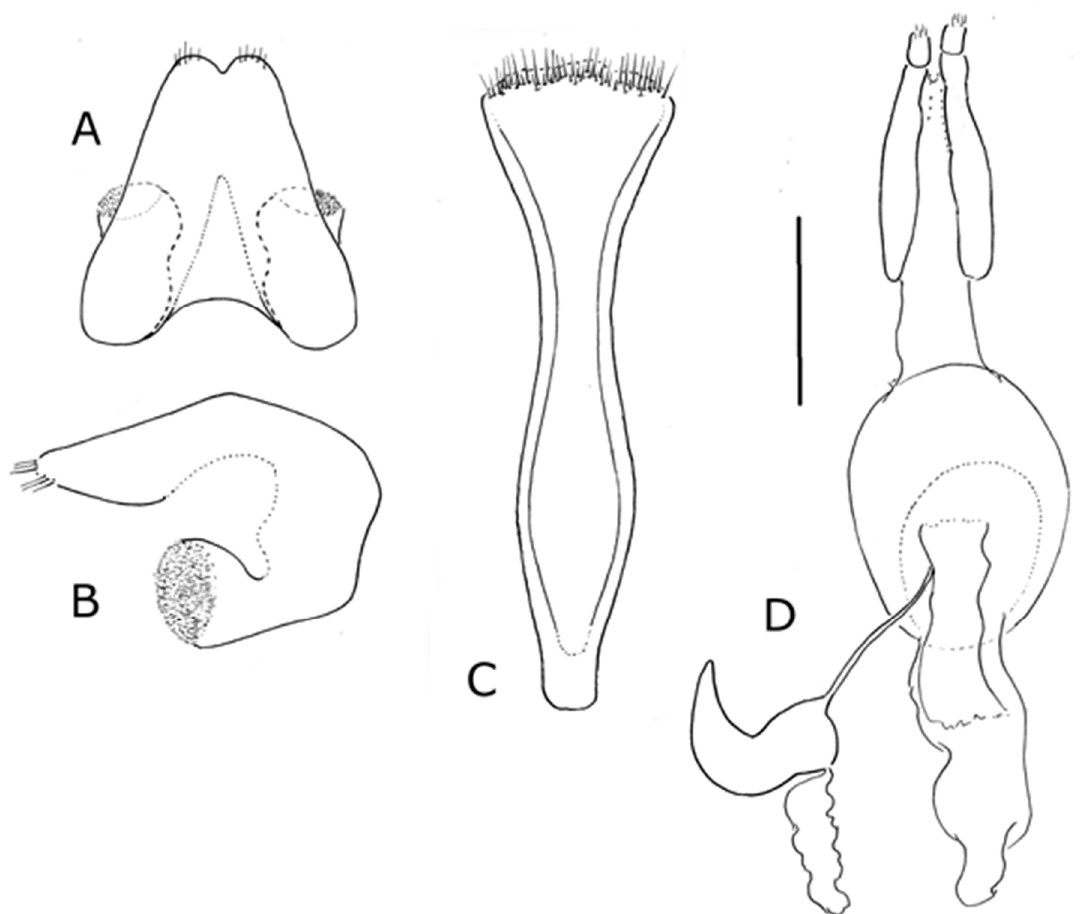
Figure 18. Sclerocardius kuscheli sp.nov., female terminalia: ( A ) tergite VIII, dorsal, ( B ) tergite VIII, lateral, ( C ) spiculum ventrale, ventral, and ( D ) genitalia, ventral. Scale bar = 0.5 mm.